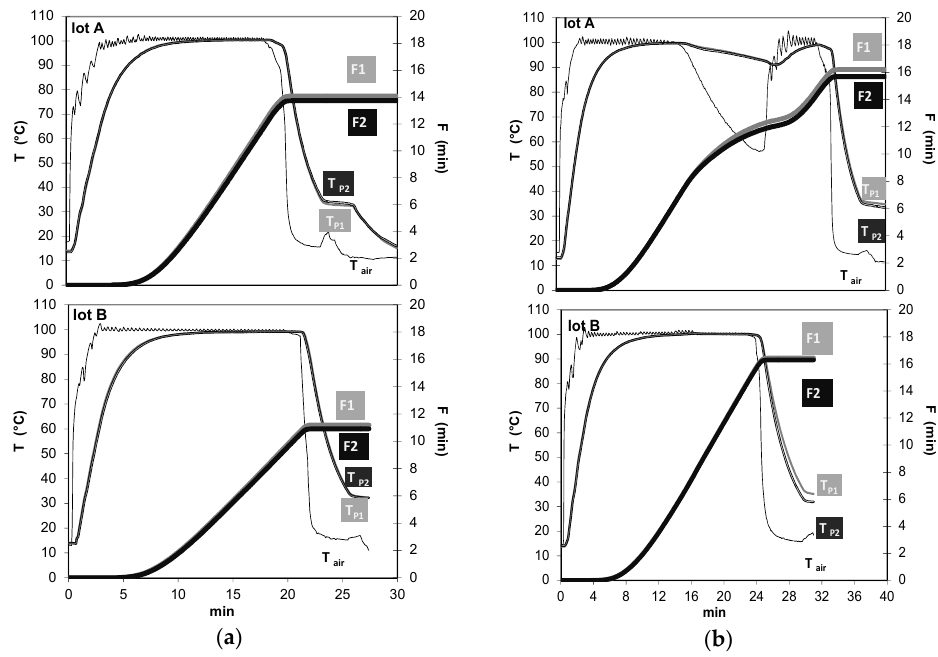
Figure 2. Time ‐ temperatures graphs and (cid:1832) (cid:2869)(cid:2868)(cid:2868)(cid:2869)(cid:2868) values of pasteurization A (top) and B (bottom) lots: ( a ) apple ‐ RCW, strawberry ‐ RCW, and blueberry ‐ RCW beverages; ( b ) pear ‐ RCW beverage. T air refers to autoclave; T P1 refers to the core of bottles put at the top of autoclave’s chamber; T P2 refers to the core of bottles put at the bottom of autoclave’s chamber; F1 is the (cid:1832) (cid:2869)(cid:2868)(cid:2868)(cid:2869)(cid:2868) value of the top bottle; F2 is the (cid:1832) (cid:2869)(cid:2868)(cid:2868)(cid:2869)(cid:2868) value of the bottom bottle.